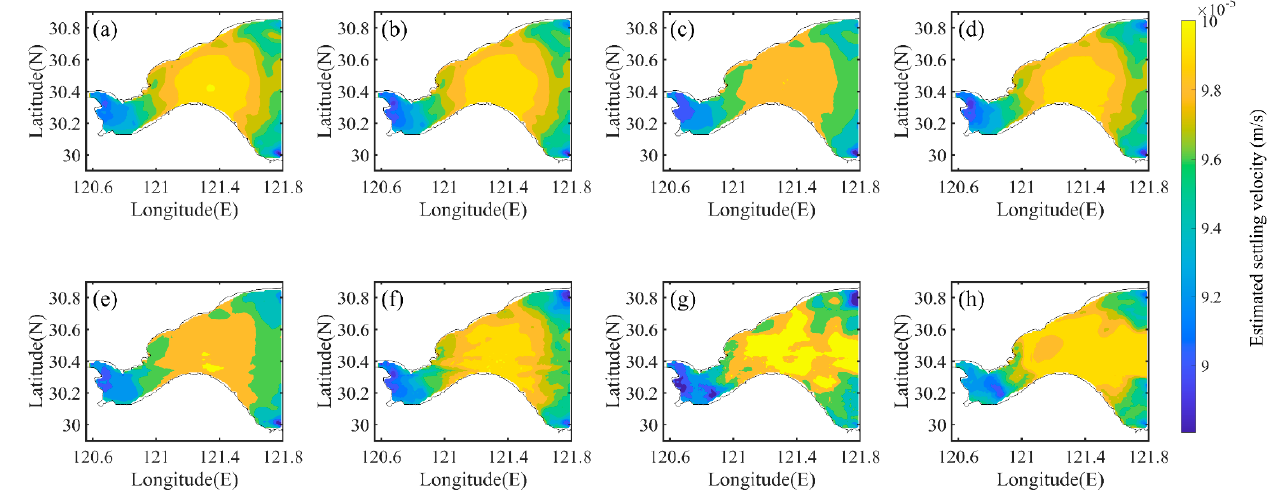
Figure 5. Spatial distribution of the estimated settling velocity in ( a ) TE01, ( b ) TE02, ( c ) TE11, ( d ) TE12, ( e ) TE21, ( f ) TE22, ( g ) TE31 and ( h ) TE32.